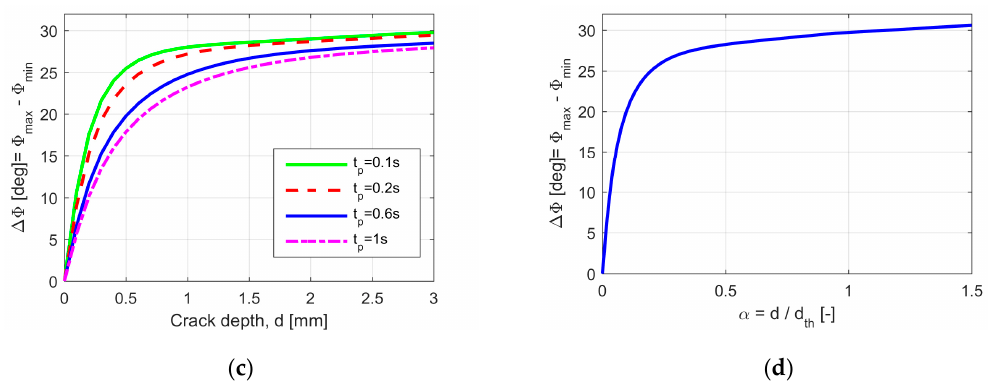
Figure 6. Temperature ( a ) and phase difference ( c ) depending on crack depth; relative temperature contrast ( b ) and phase difference ( d ) depending on the relative crack depth α , calculated with Equations (4)–(7) for ferro-magnetic steel material parameters.